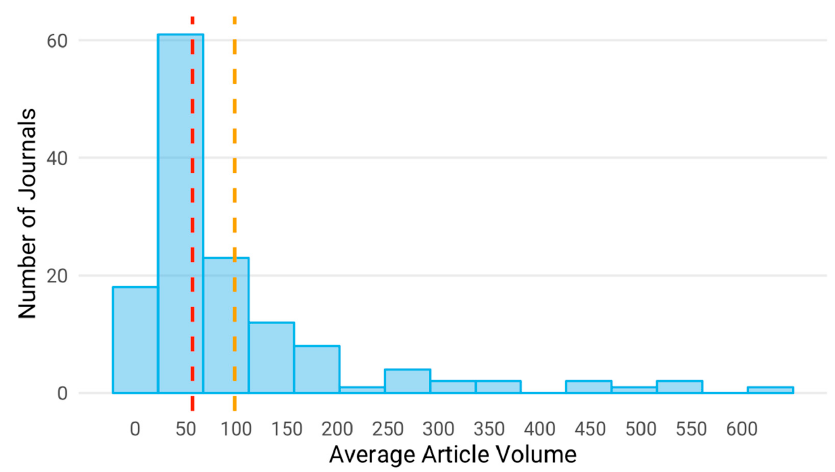
Figure 5. A histogram of the average article volume per year. The red dashed line represents the median (56), and the yellow dashed line shows the mean (98) value of the distribution.